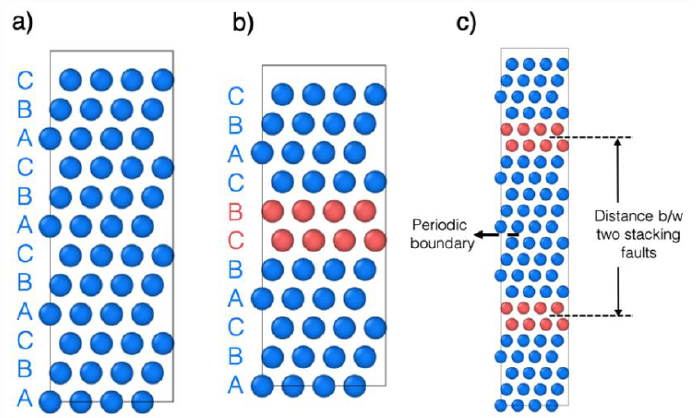
Figure 2. ( a ) ABCABC ... planar stacking in the fcc structure. ( b ) Stacking fault in the planar sequence resulting in local hcp structure as shown by red colored atoms. ( c ) Schematic representing a minimum distance between two periodically repeating stacking faults used in the simulations.